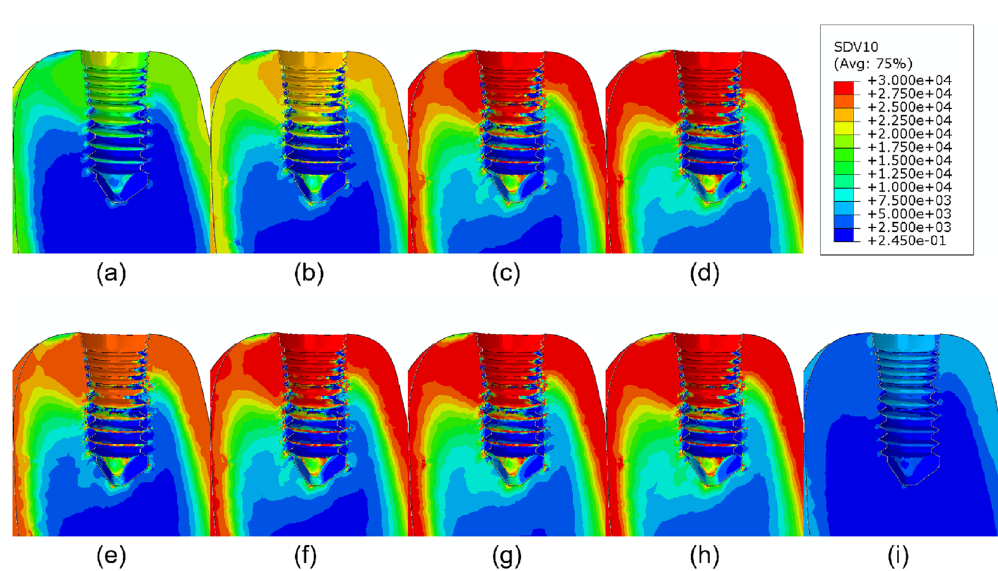
Figure 10. Elastic modulus distribution after 540 days of simulation for different doses of ( a ) 0.1, ( b ) 0.3, ( c ) 1.0, ( d ) 3.0 mg/kg of denosumab and doses of ( e ) 0.25, ( f ) 0.5, ( g ) 1.0, ( h ) 2.0 mg of bisphosphonates and ( i ) control